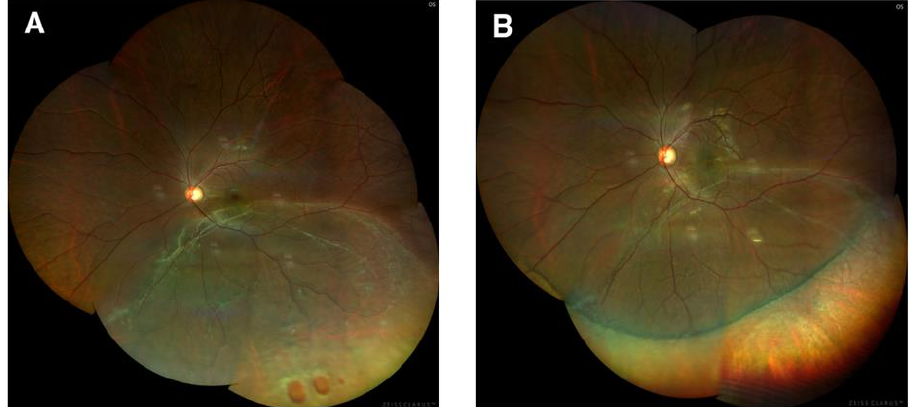
Figure 1. A 32-year-old woman showed rhegmatogenous retinal detachment with a peripheral break ( A ) and was successfully treated with scleral buckling surgery ( B ).